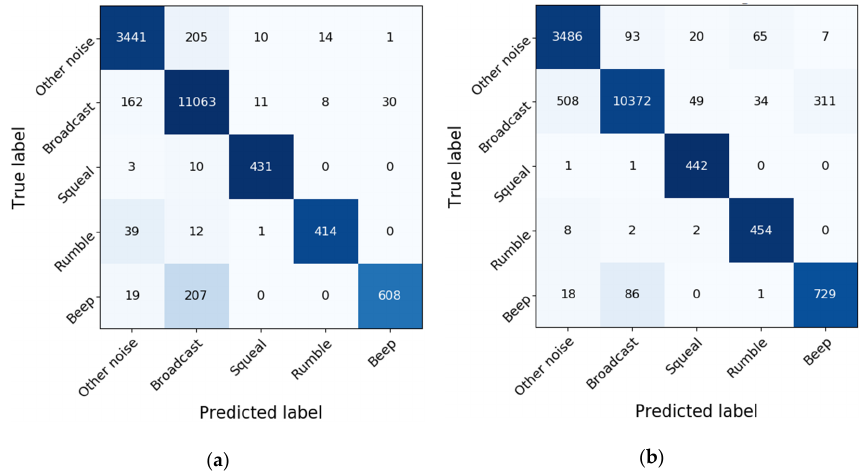
Figure 7. Confusion matrices of test results: ( a ) Model trained with unbalanced data; ( b ) Model trained with balanced data.